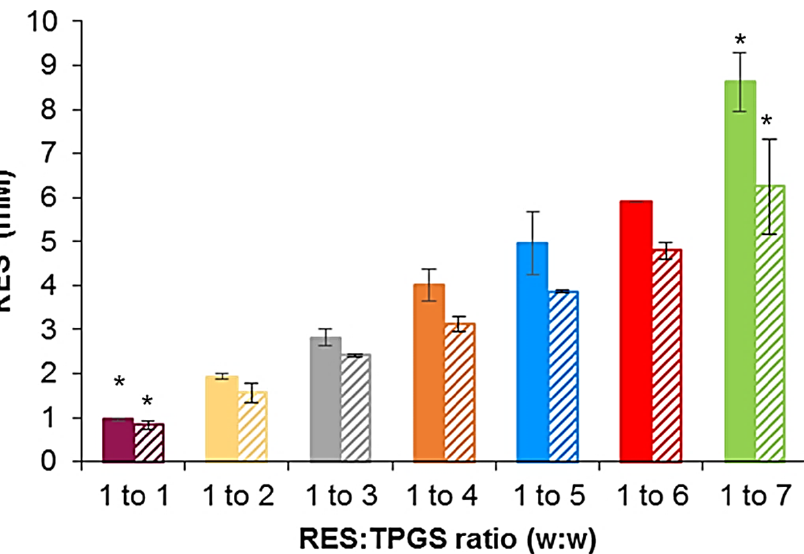
Figure 3. RES total solubility obtained via the solvent casting method and the solvent diffusion evaporation method (striped columns) as a function of the RES:TPGS w:w ratio present in the starting mixture. Histogram summarizing the quantitative data of the means ± S.D. of six independent experiments. * Statistically significant difference vs. formulations prepared by the same method but containing different TPGS concentrations. No statistically significant differences were observed between formulations having the same polymer concentration but prepared using different methods (F-test (ANOVA) and t -test, α = 0.05, degree of freedom =